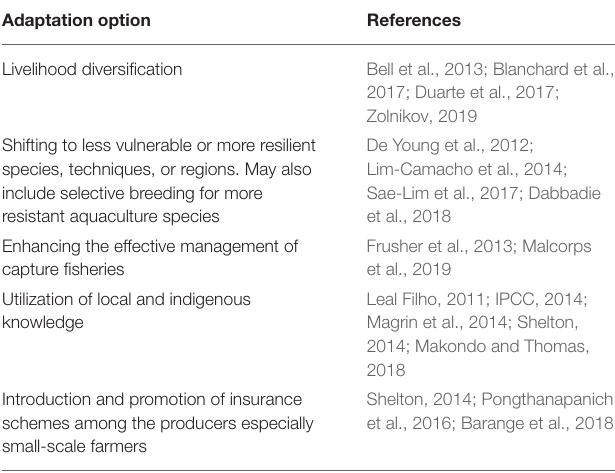
TABLE 2 | Some adaptation options to climate change effects on aquaculture that may be applied in many regions